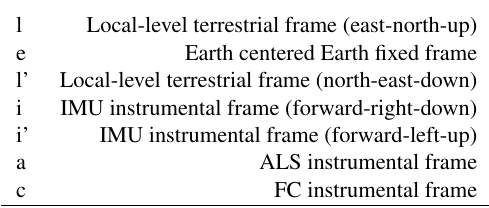
Table 1: Reference frames and coordinate